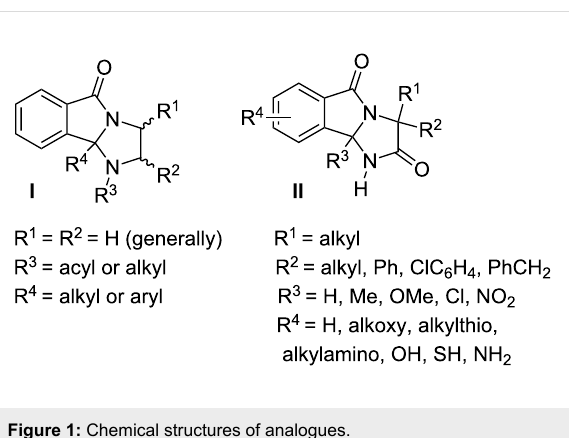
Also, the imidazo[2,1- a ]isoindole-2,5-dione derivatives of primaquin have been synthesized from α -amino acids